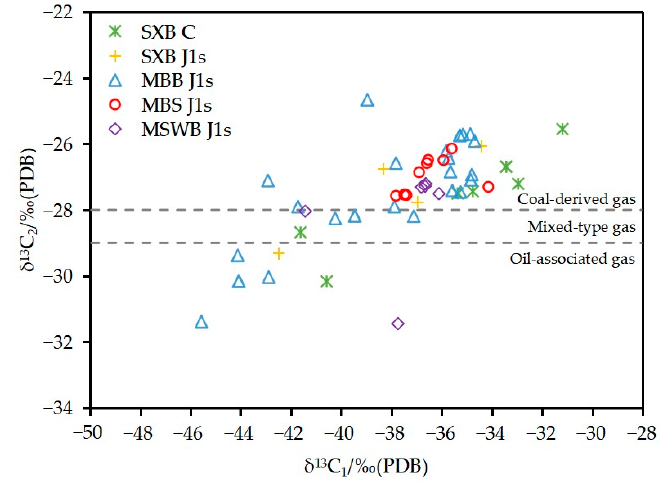
Figure 4. Genetic types identification chart for natural gases in the eastern belt around the Penyijingxi sag, Junggar Basin based on δ 13 C 2 & δ 13 C 1 (plate from ref. [11]).